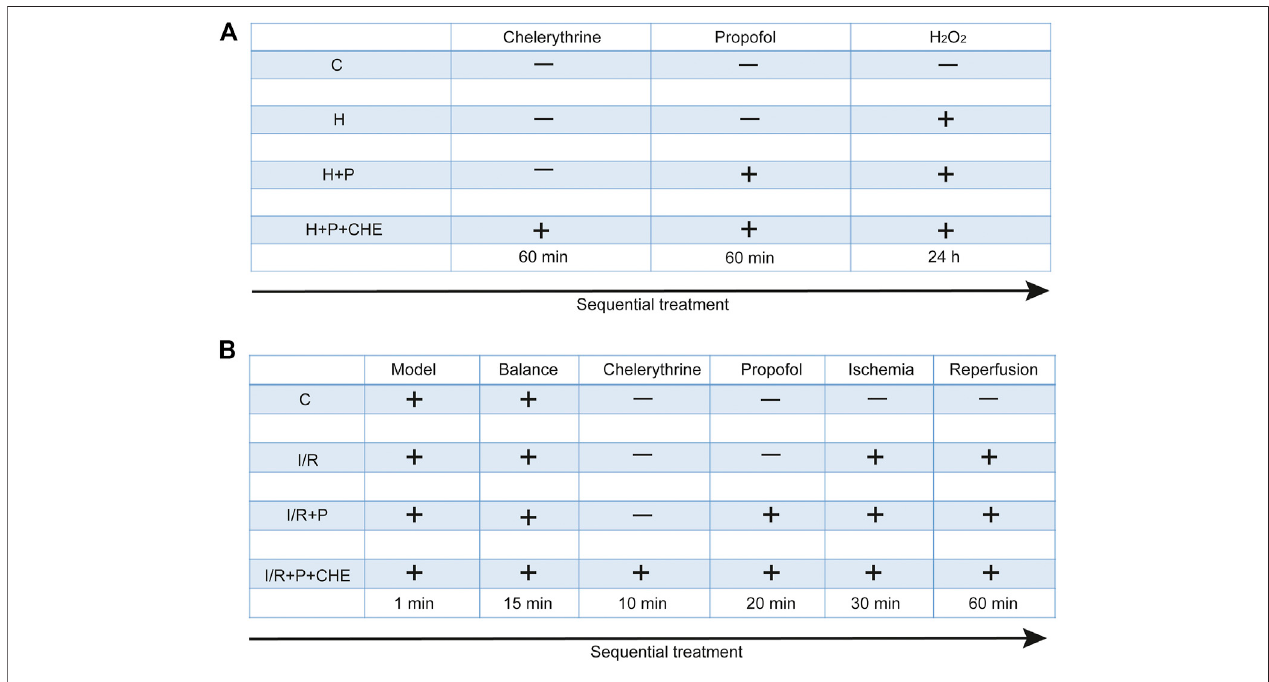
FIGURE 2 | Experimental grouping and corresponding treatment on H9C2 cells (A) and rat heart (B) .